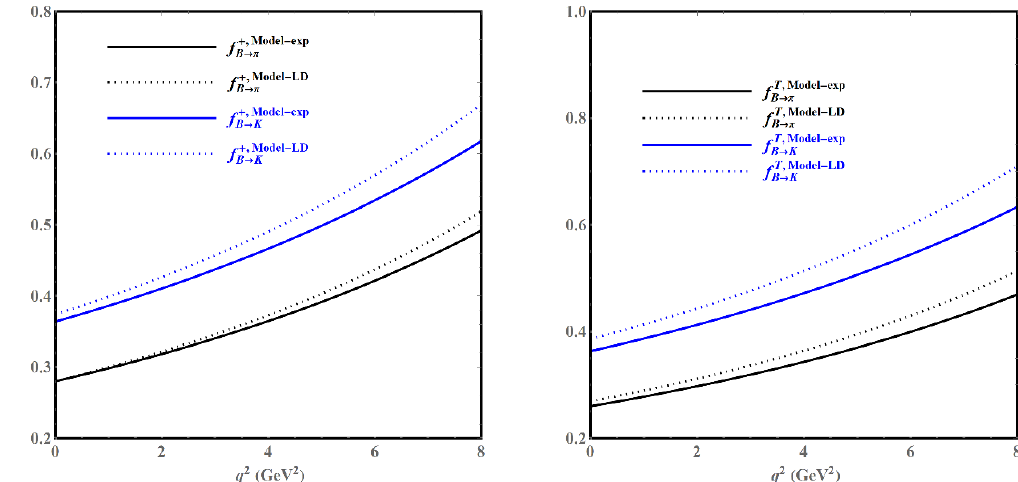
Figure 6 . Dependence of the B ! (cid:25); K form factors on the nonperturbative models of B -meson LCDAs at 0 (cid:20) q 2 (cid:20) 8 GeV 2 . The observed pattern for the scalar form factors f 0 f 0 ( q 2 ), in analogy to the corresponding behaviours for the vector form factors, are not presented B ! K here for